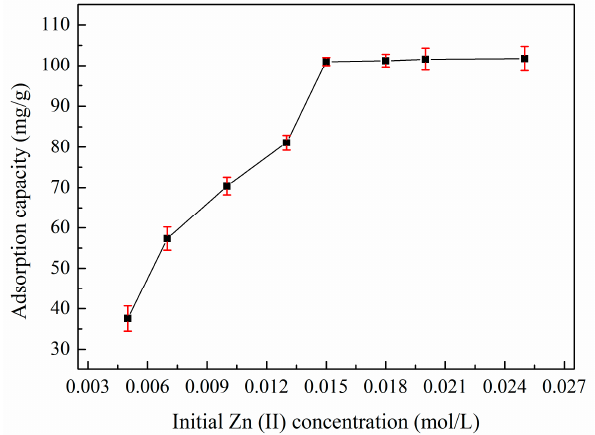
Figure 8. Effect of initial zinc(II) concentration on the adsorption capacity of XSBLAC for zinc(II). (Adsorption experiments-sample dosage: 0.05 g; initial zinc(II) concentration: 0.005–0.025 mol/L; pH value: 5.16; temperature: 60 ◦ C; adsorption time: 40